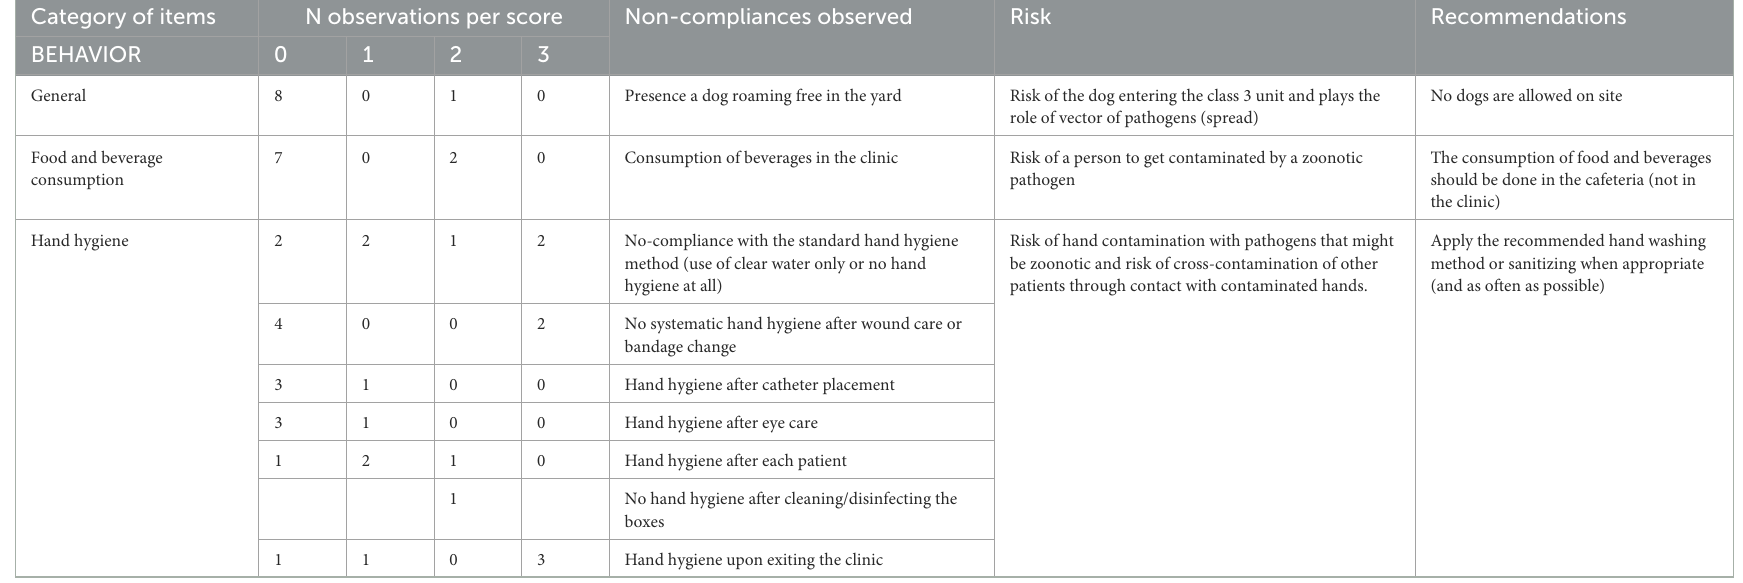
TABLE 2B Biosecurity deficiencies observed when performing the internal audit in the Equine class 3 area—category “BEHAVIOR”. Category of